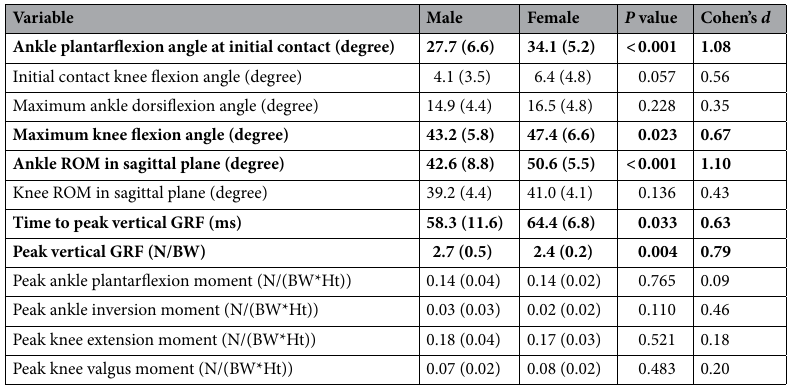
Table 1. The mean (standard deviation) value of sex comparison of biomechanical variables during single-leg landing. Significant values are in